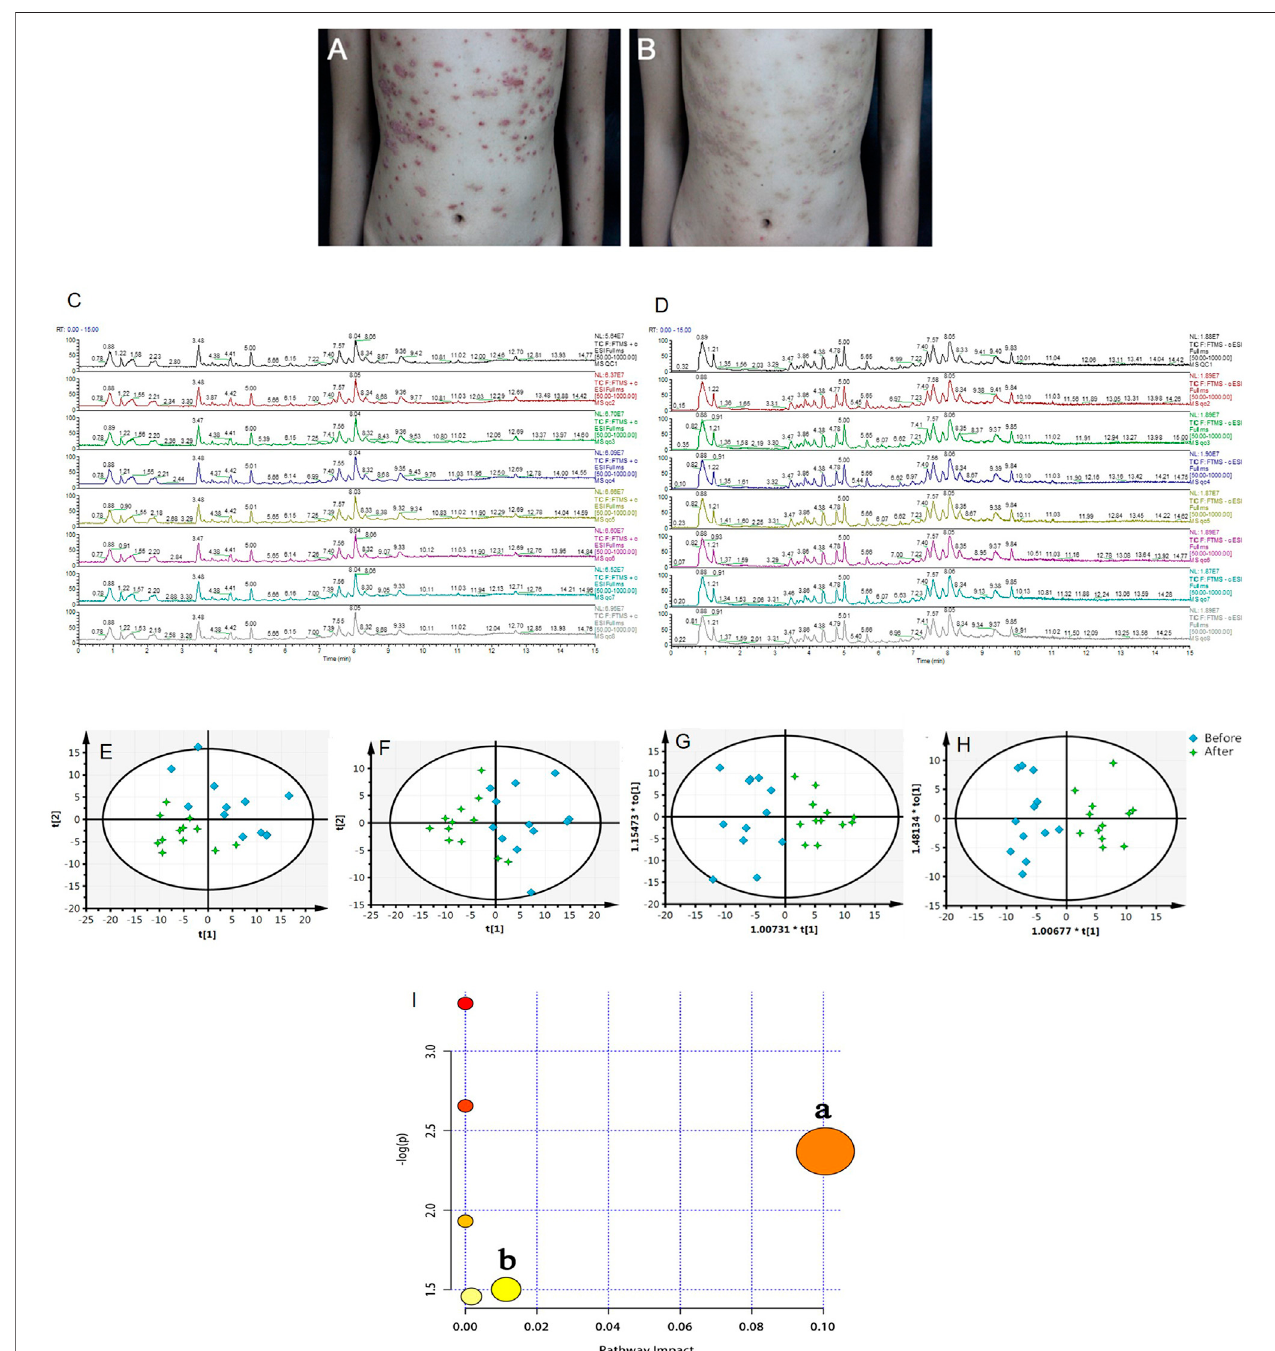
FIGURE 4 | (A, B) Representative photographs of the patient with psoriasis taken at baseline (week 0, A) and after 8 weeks (B) of treatment with LiangxueJiedu formula. Total ions chromatogram of QC samples from the positive (C) and negative (D) ion scan modes. (E, F) PCA score plots of serum samples collected from psoriasis patients before and after 8 weeks of LiangxueJiedu formula treatment measured in (E , R 2 X (cid:2) 0.724, Q 2 (cid:2) 0.495 ) positive and (F , R 2 X (cid:2) 0.574, Q 2 (cid:2) 0.371 ) negative mode. (G, H) OPLS-DA score plots of serum samples collected from psoriasis patients before and after 8 weeks of LiangxueJiedu formula treatment basedonUPLC-Q-TOF/MStechnologyin(G, R 2 X (cid:2) 0.557, R 2 Y (cid:2) 0.782,Q 2 (cid:2) 0.671)positiveand(H, R 2 X (cid:2) 0.410, R 2 Y (cid:2) 0.852,Q 2 (cid:2) 0.453)negativemode. (I) Summary of pathway analysis with MetPA, a: glycerophospholipid metabolism; b: steroid hormone biosynthesis.